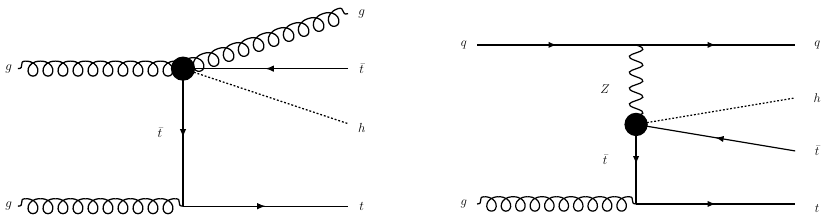
Figure 8 . Example diagrams that contribute to t¯th . The EFT vertex in the diagram on the left is a c vertex, and the QED order of the diagram is 1; we can therefore take this contribution into t G account at NLO. For comparison, the diagram on the right contains a c order of the diagram is 3; we therefore cannot easily take this contribution into account at